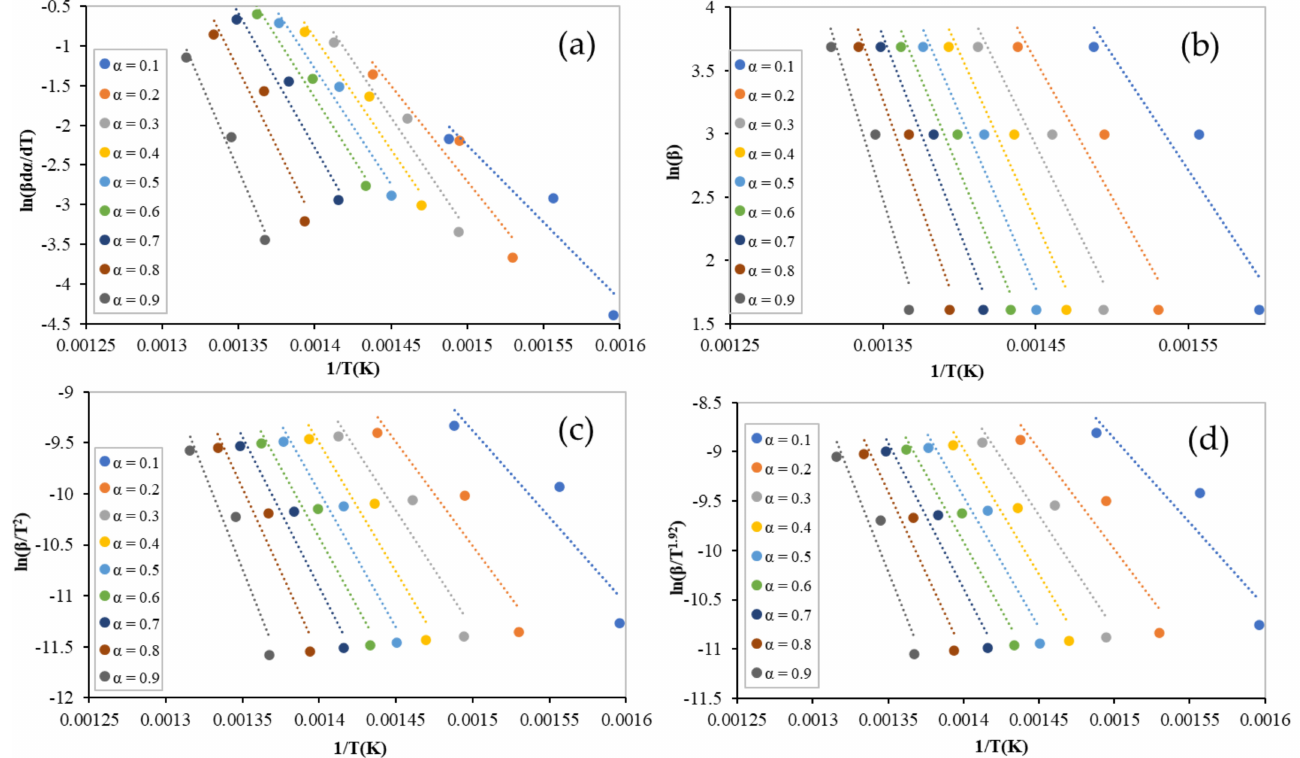
Figure 4. Linear regression lines of ternary equi-mass PP, PS, and LDPE mixtures at different conversions by: ( a ) Freidman; ( b ) FWO; ( c ) KAS; and ( d )